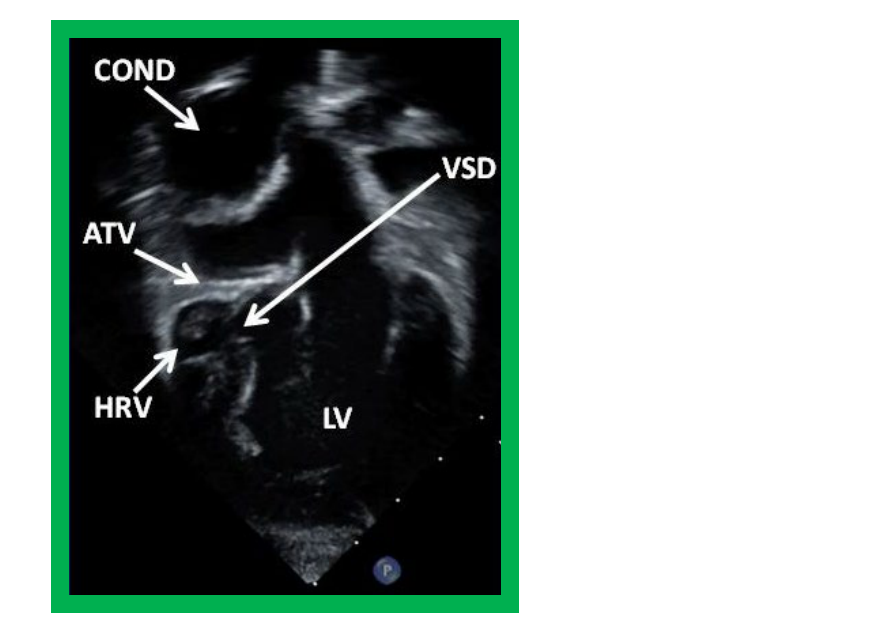
Figure 39. Selected video frame from an apical four-chamber view demonstrating the left ventricle (LV), hypoplastic right ventricle (HRV) with an atretic tricuspid valve (ATV) in a patient who had Fontan procedure. Cross-sectional view of the conduit (COND) is also shown. Note small ventricular septal defect (VSD) (long arrow).